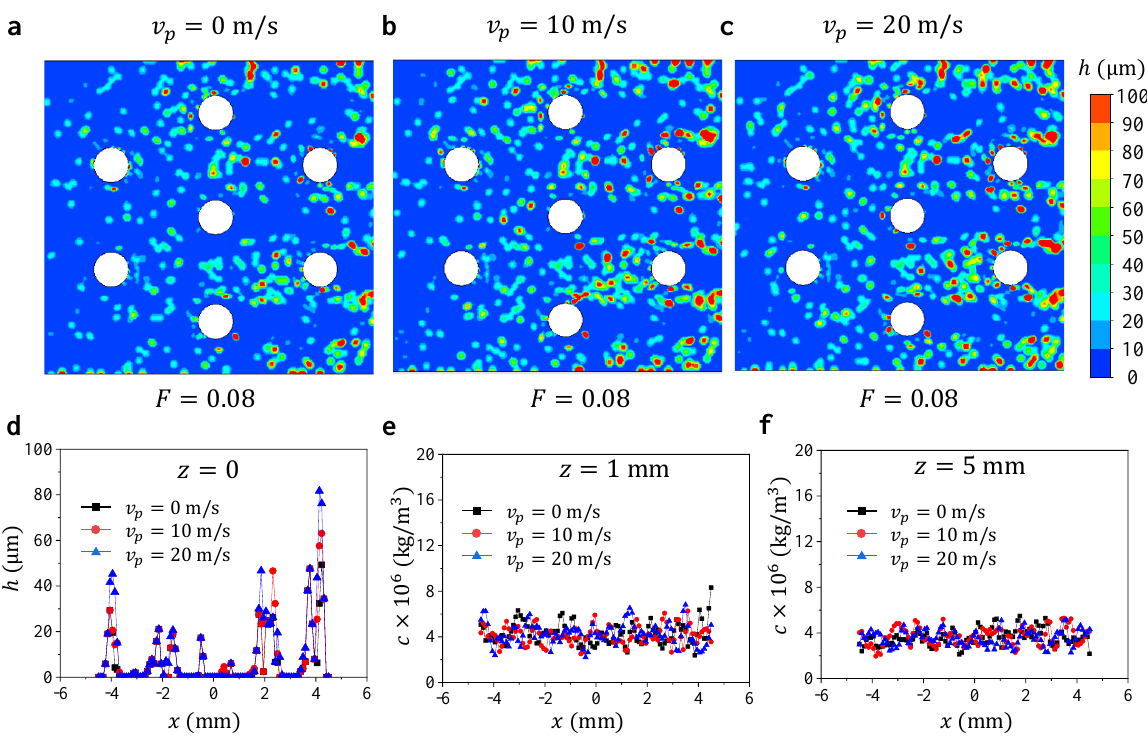
Figure 4. Contours of particle deposition thickness h at F = 0.08 with different V p : ( a ) V p = 0m/s, ( b ) V p = 10m/s, and ( c ) V p = 20m/s. ( d ) The deposition thickness h along x direction on the surface at y = 1.5mm. The particle mass concentration c along x direction at ( e ) ( z = 1mm, y = 1.5mm) and ( f ) ( z = 5mm, y =